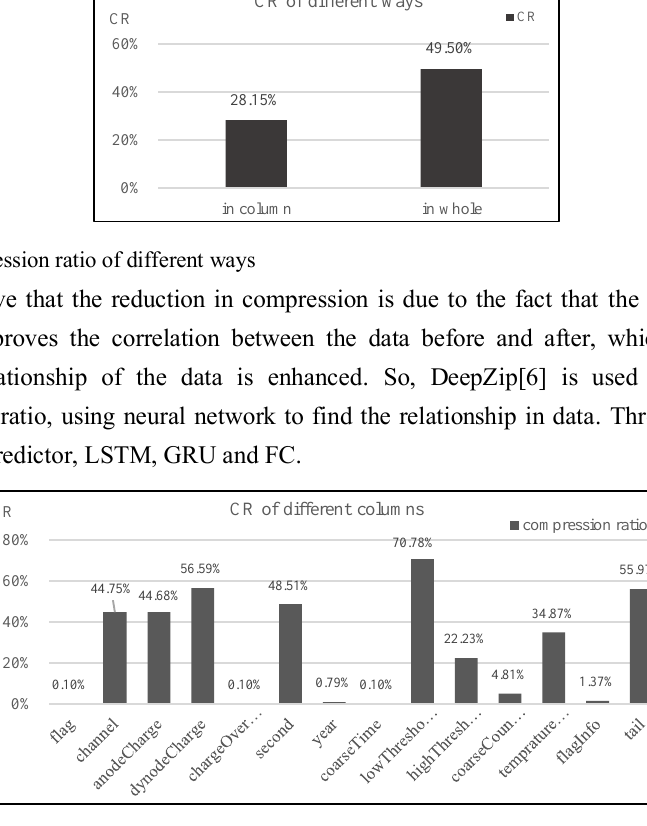
Fig. 7. Compression ratio of different columns